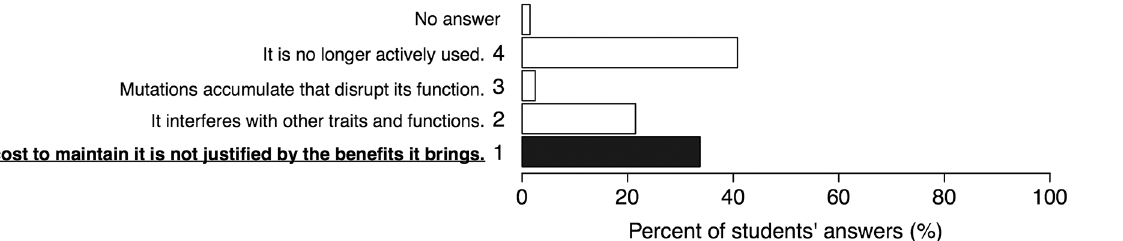
Fig 1. Results on questions 4, 5 and 11. On three out of four BCI questionsrelated to evolutionary processes, many participants were attracted by distractors underlyingmisconceptions such as "needs as a rationalfor changes"or "use and disuse of an organ". The best answers are in